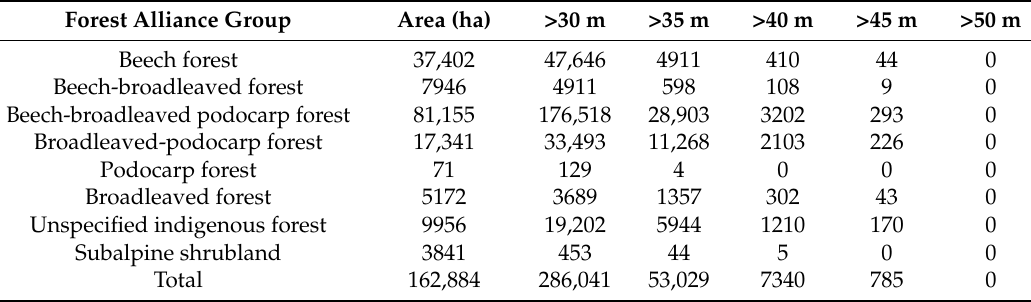
Table 3. Number of trees in forest alliance groups in selected tree-height ranges. Forest Alliance